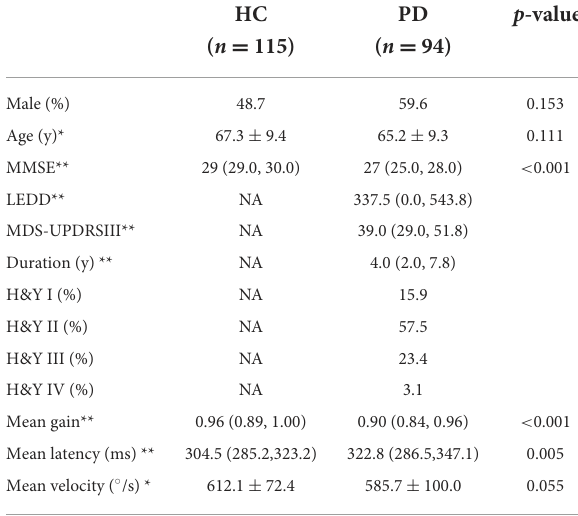
TABLE 1 Characteristics and reflexive saccadic parameters of